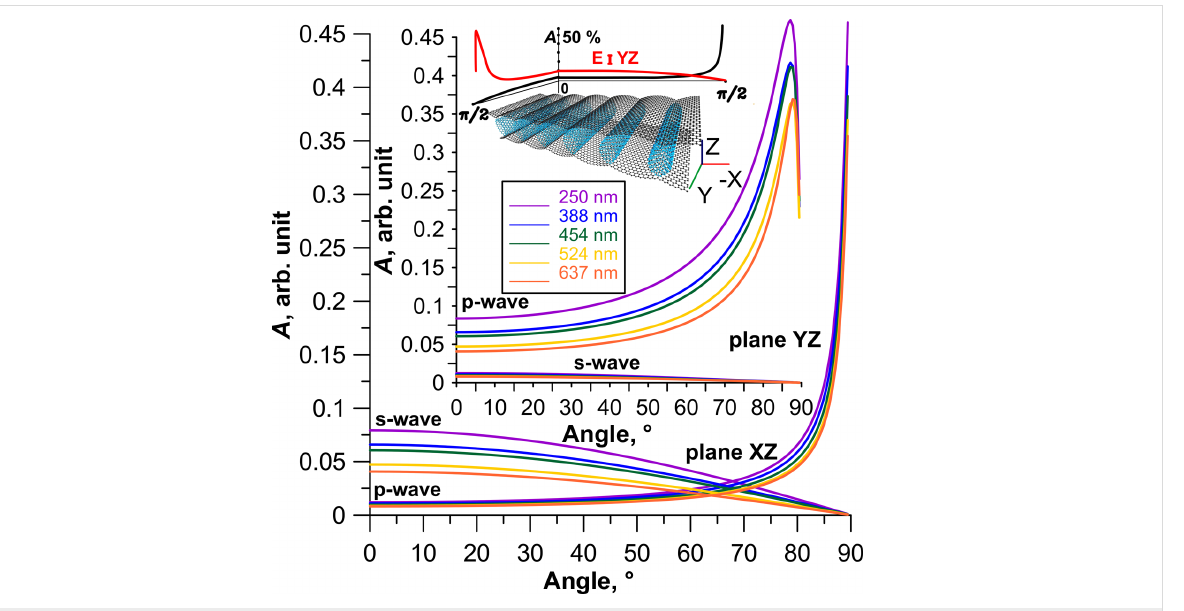
Figure 7: Absorption coefficient of a 2D CNT–graphene hybrid nanocomposite (tube (18,0), 13 hexagons intertube distance) as a function of the angle of incidence at different